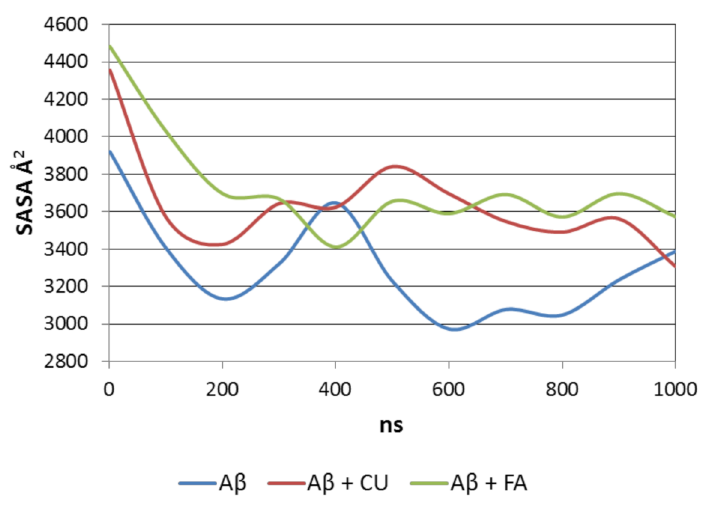
Figure 6. SASA averaged over every 100 ns of the production trajectory of A β peptide in the three modelled systems.